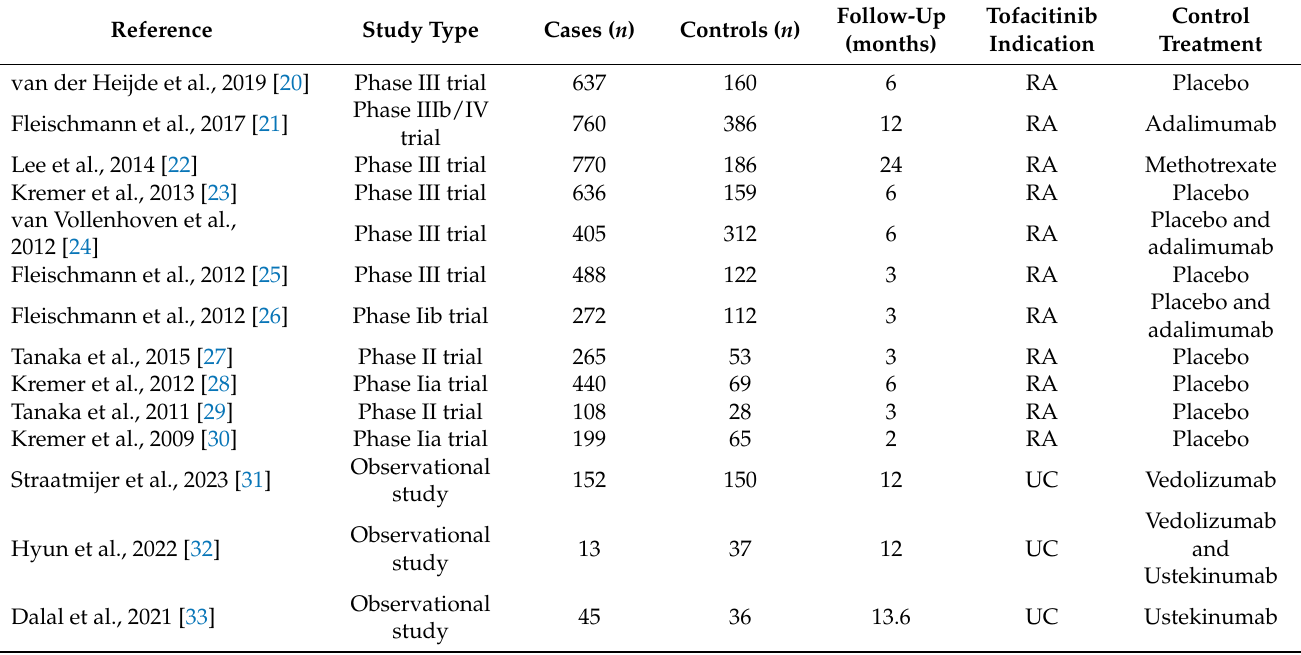
Table 1. General characteristics of the studies reported in 22 articles selected for analysis.